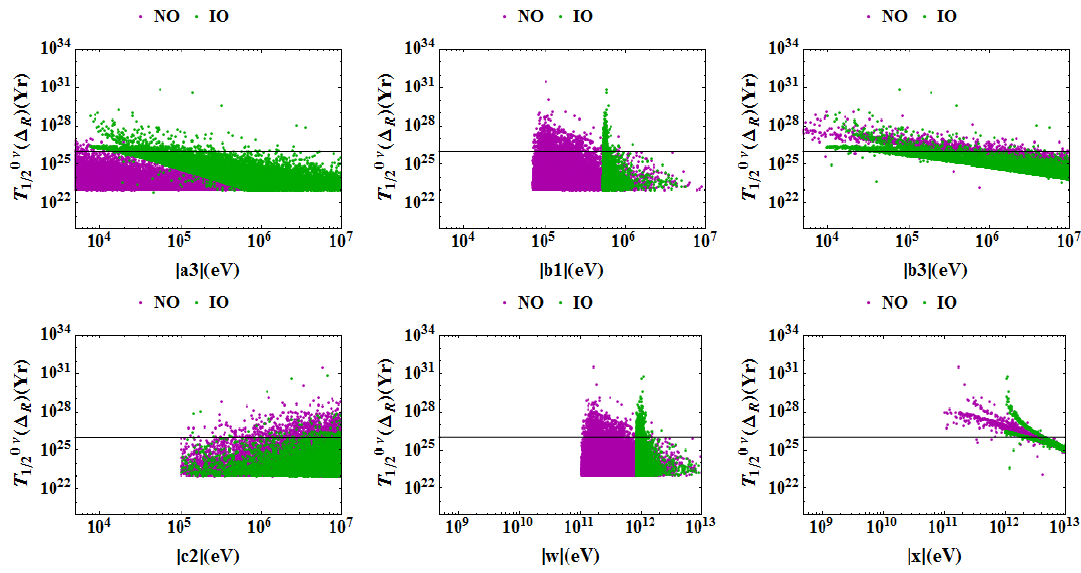
JHEP06(2019)064 Figure 14 . Heavy (cid:1) R contribution to half-life governing NDBD as a function of model parameters for the class B2. The horizontal line represents the KamLAND-Zen lower limit. Figure 15 . Heavy (cid:23) (N) contribution to half-life governing NDBD as a function of model param- eters for the class B3. The horizontal line represents the KamLAND-Zen lower limit. { 26